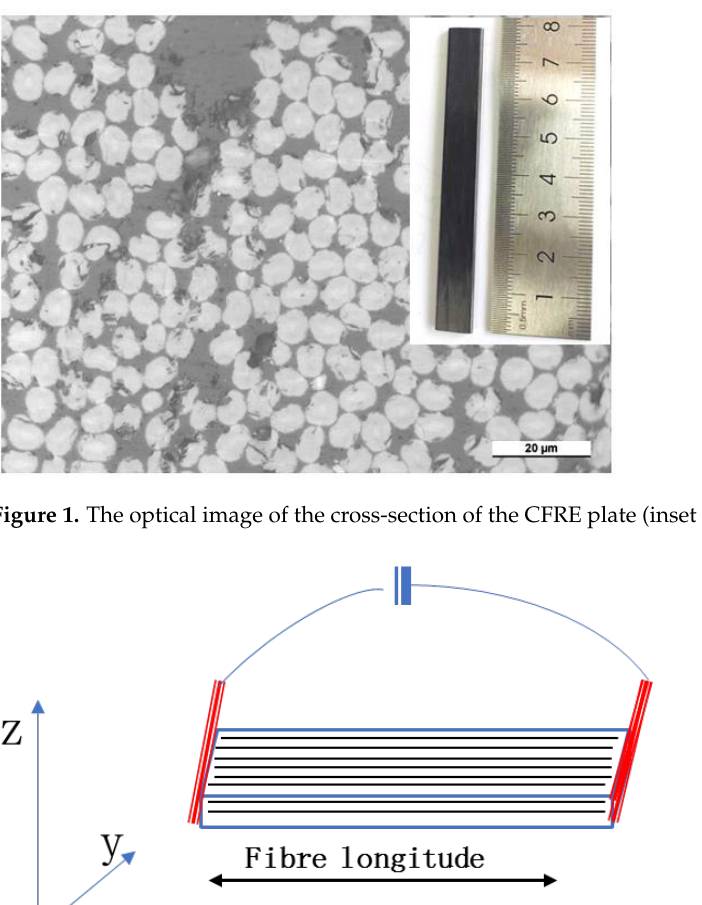
Polymers 2022 , 14 , x FOR PEER REVIEW 3 of 12 2. Experimental Materials and Instruments The type of carbon fiber used in the CFRE composite sheet used for this test was T